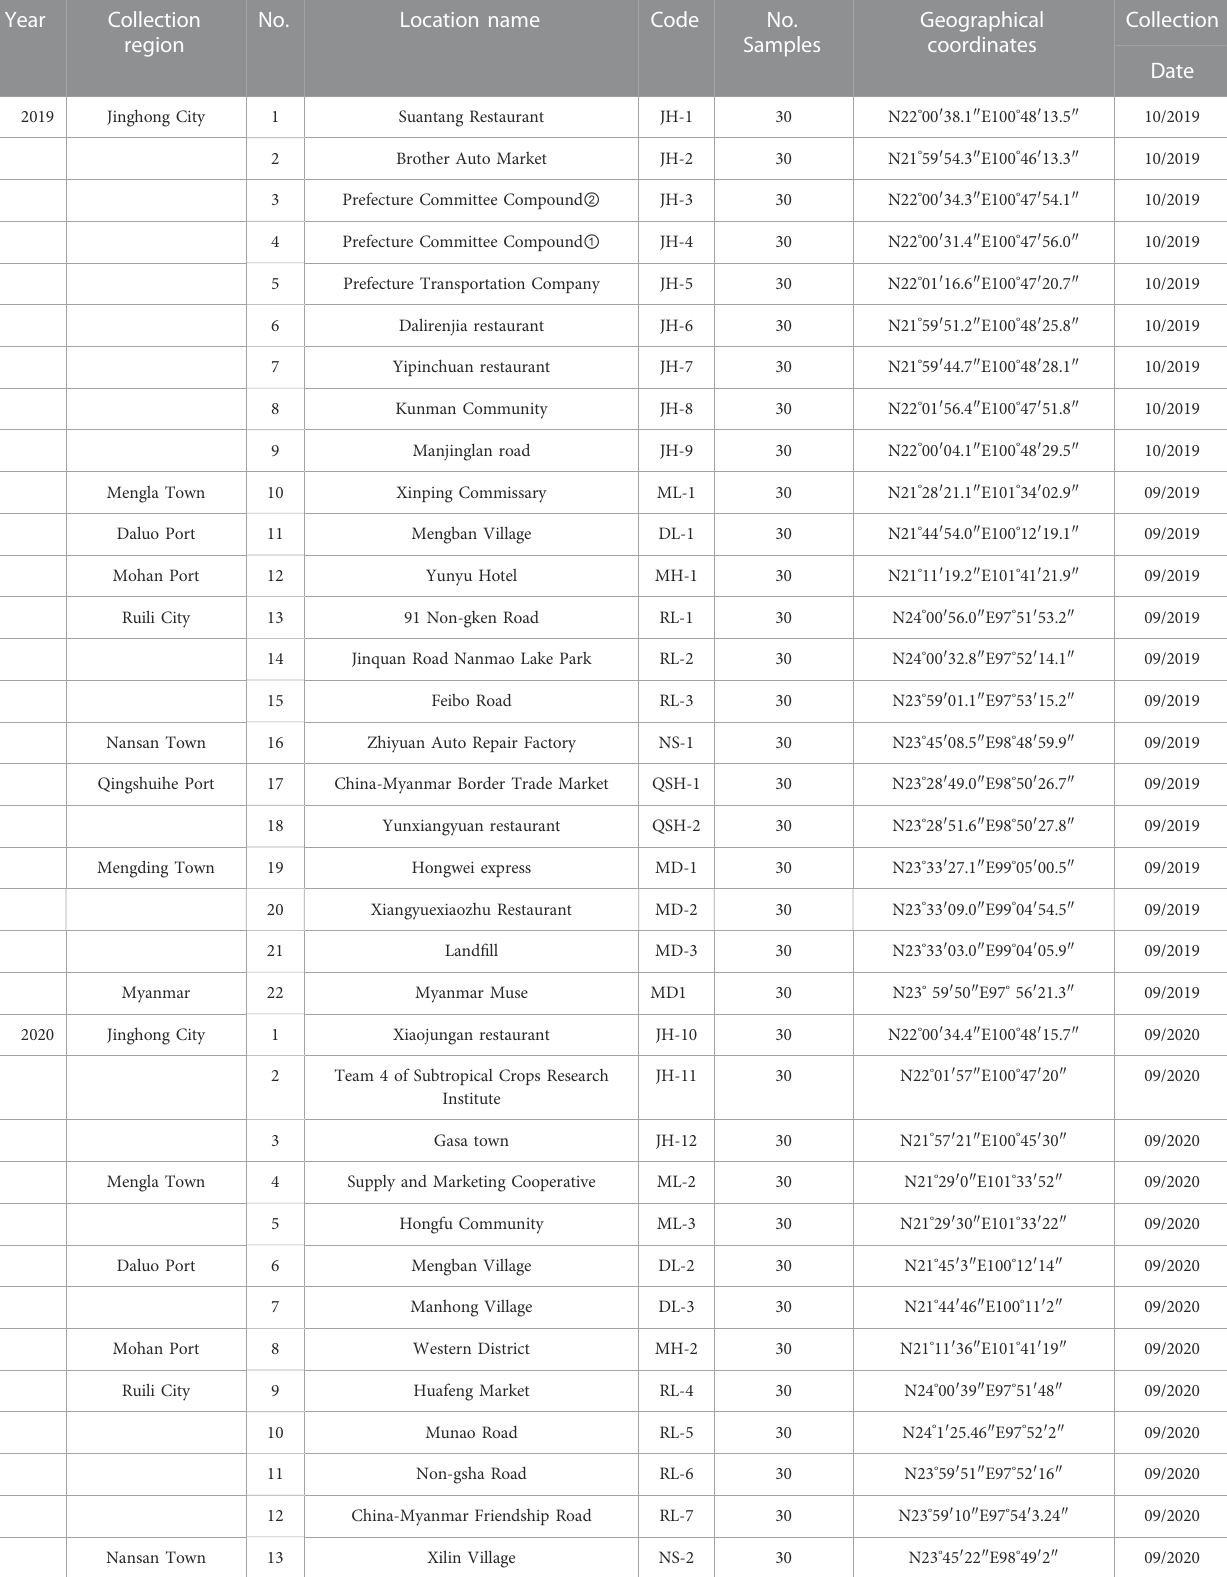
TABLE 1 Detailed information on the fi eld sampling sites in Yunnan Province, 2019 and 2020.